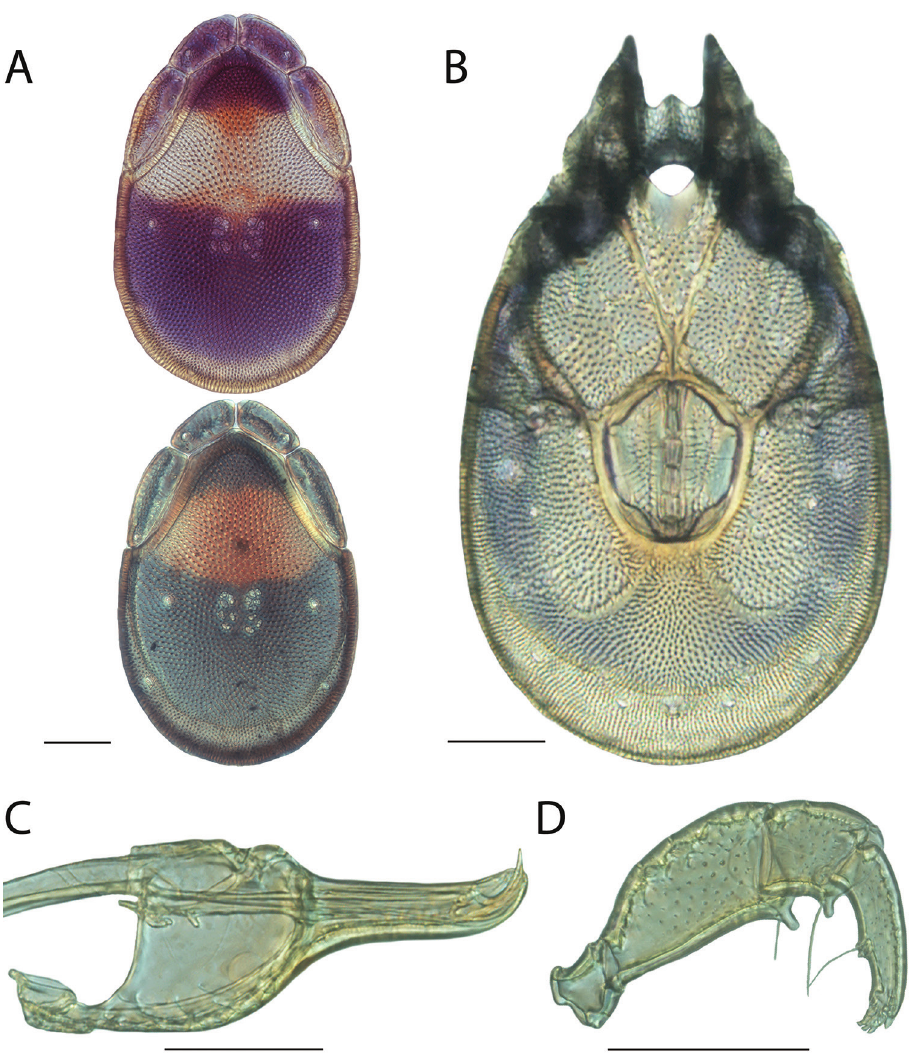
Figure 91. Torrenticola gorti sp. n. female, Tennessee specimen depicted except for A (top): A dorsal plates, note variation in color between Tennessee specimens (bottom) and elsewhere (top) B venter (legs removed) C subcapitulum D pedipalp (setae not accurately depicted). Scale = 100